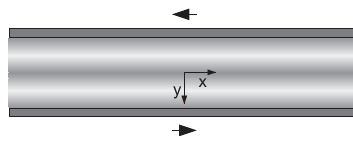
Figure 5: Load case 3 illustration